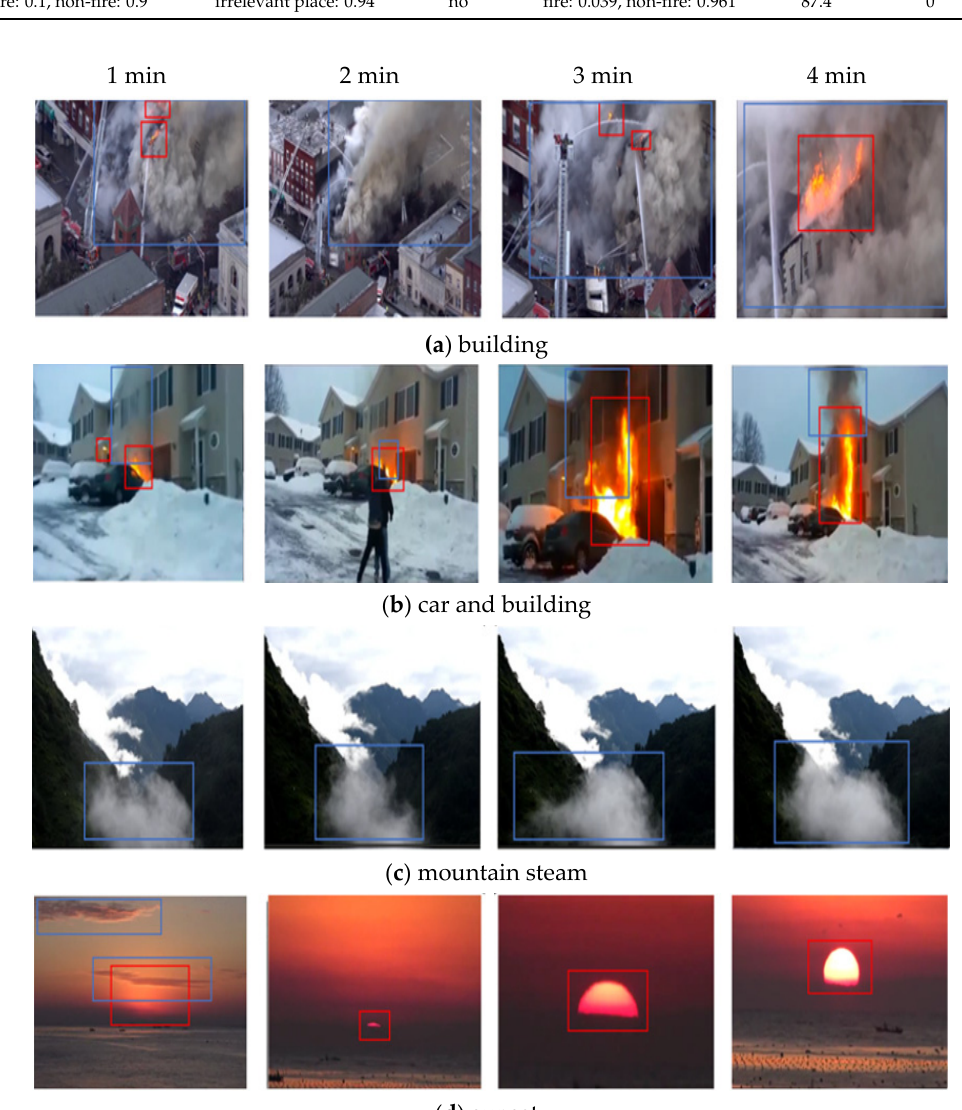
Figure 12. Sample still shots taken from video clips for the experiment [26]. The ( a ) and ( b ) images are fire videos, while the ( c ) and ( d ) images non-fire video clips.